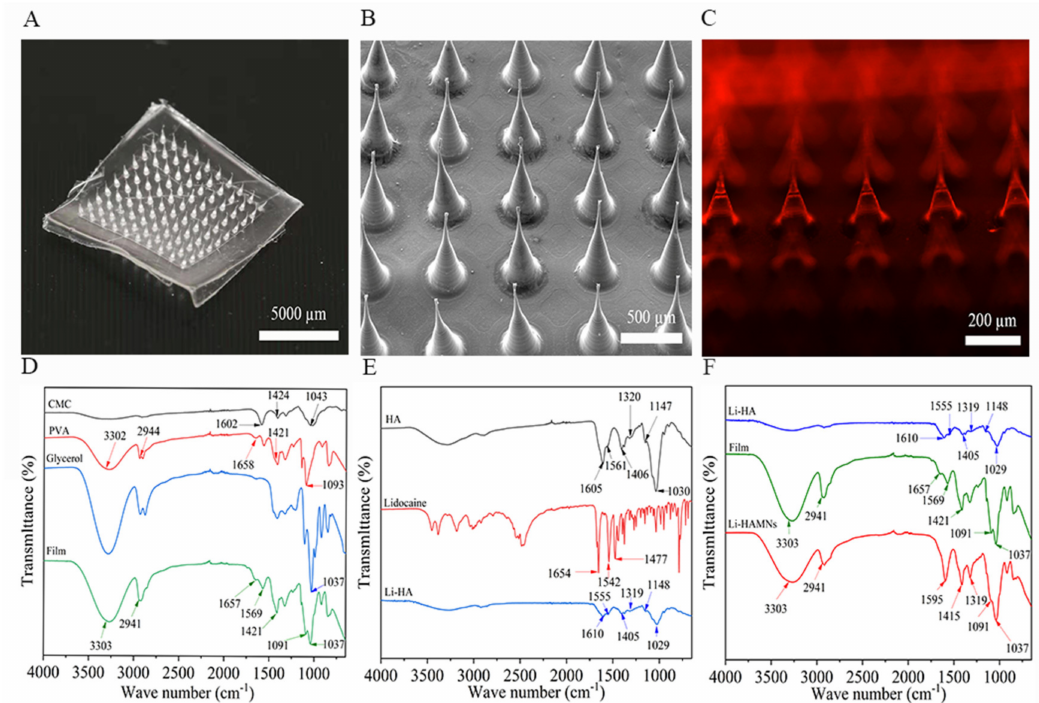
Figure 1. Evaluation of the physical properties of the blended film and Li-HAMNs. ( A ) The photo- graph of the Li-HAMN patch. Scale bar, 5000 µ m. ( B ) SEM images of the Li-HAMN array. Scale bar, 500 µ m. ( C ) Confocal micrographs of fluorescent Li-HAMNs. Scale bar, 200 µ m. ( D ) FTIR spectrum of CMC-Na, PVA, glycerol, and blended film. ( E ) FTIR spectrum of HA, lidocaine, and Li-HA. ( F ) FTIR spectrum of Li-HA, blended film, and